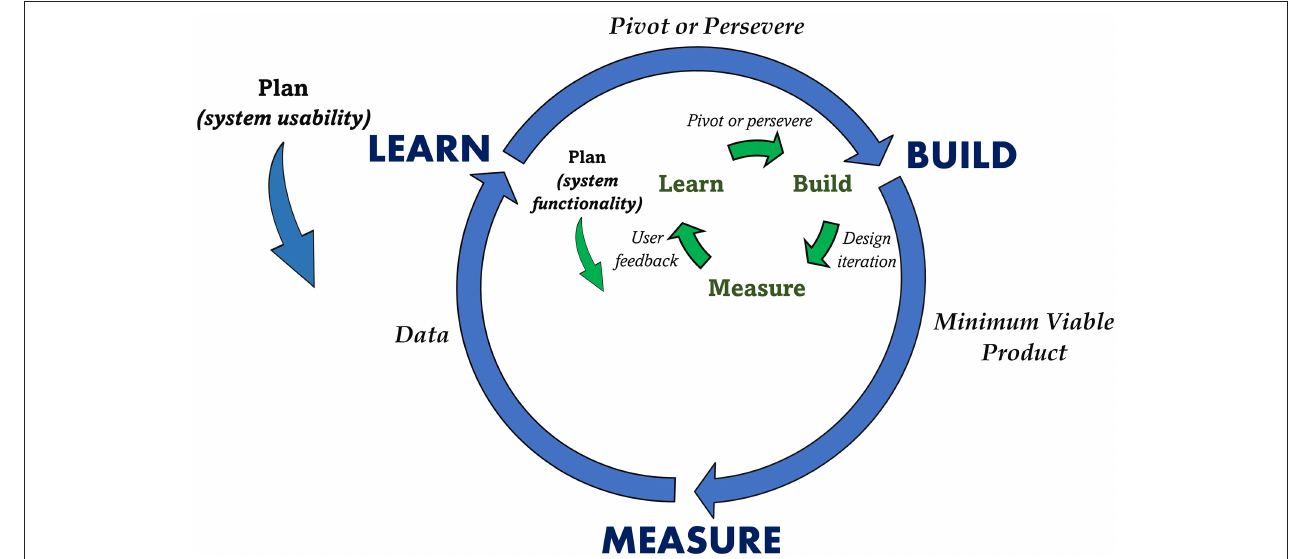
FIGURE 4 | Build-Measure-Learn cycle in Lean Startup framework (Reis,